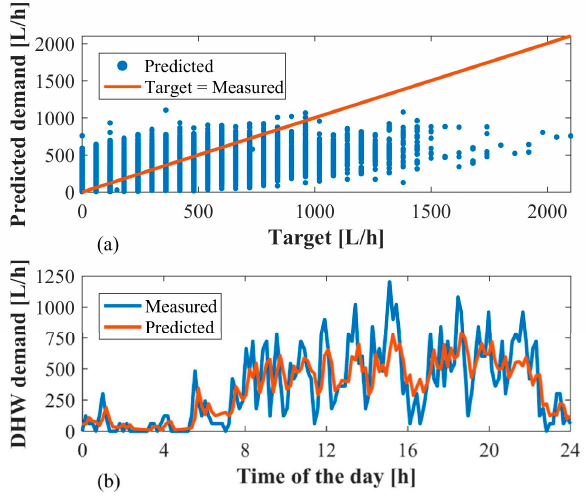
Figure 2. ( a ) Distribution of the predictions made and ( b ) daily consumption profile for a selected day with the